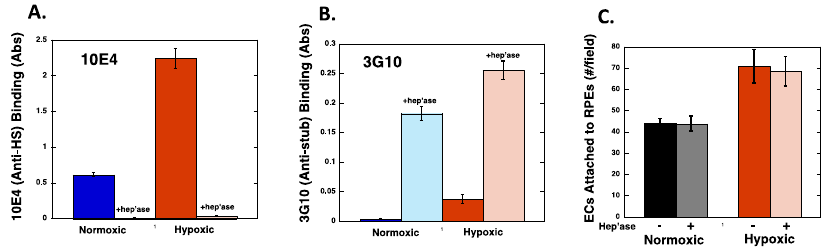
Figure 7. Heparan sulfate chain composition is altered by hypoxia. ( A , B ) RPE cells were maintained under normoxic or hypoxic (1% pO 2 ) conditions for 72 h. During the last 2.5 h of culture, the cells were treated with or without 0.25 units / mL Heparinase III at 37 ◦ C (hep’ase) prior to fixing. The cells were washed, fixed, blocked, and incubated with anti heparan sulfate antibodies clone 10E4 ( A ) or clone 3G10 ( B ) and HRP linked goat anti mouse IgG was used to detect 10E4 and 3G10. The data is expressed as blank corrected absorbance values corrected for cell number ± SEM where N = 4 for each condition. ( C ) After the hypoxia conditioning period and 2.5 h heparinase III treatment, RPE cells were washed and fluorescently labeled RECs allowed to attach for 1 h, washed, fixed, and counted. Data (4 fields / well; 3 wells / condition; n = 4; N = 3) is expressed as the average number of cells per field ± SD. Statistical analysis revealed that hypoxia significantly increased 10E4 and 3G10 binding to RPE cells ( A and B ), and that hypoxia increased REC attachment to RPE cells ( C ).